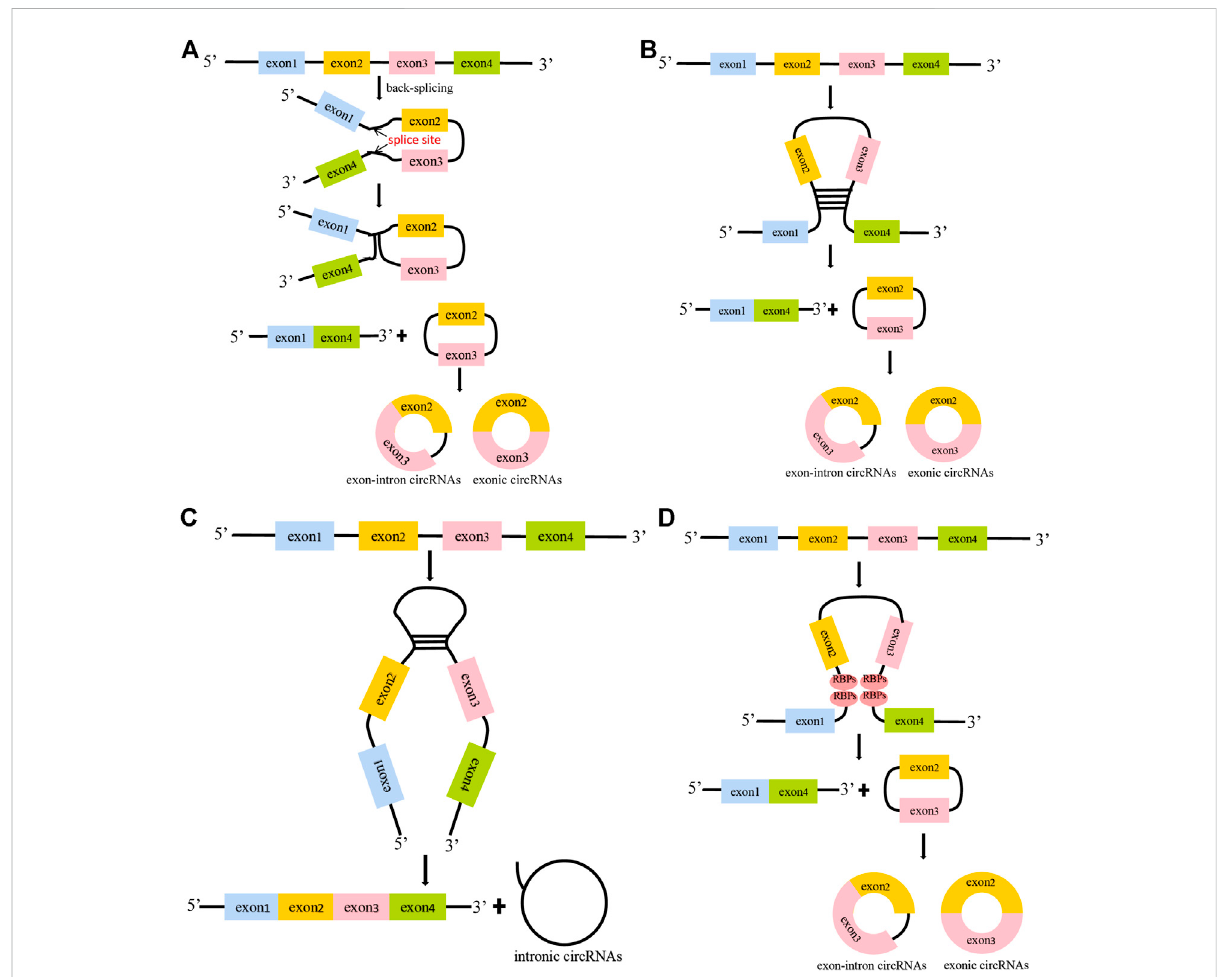
FIGURE 2 TheformationmechanismsofcircularRNAs. (A) .Lariat-drivencircularization.Thesplicedonorofthedownstreamexonofthepre-mRNAbinds to the splice acceptor of the upstream exon, thereby forming exon-intron circRNAs. When the introns are removed, the exons are linked by 3 – 5 ′ phosphodiester bonds to form exonic circRNAs. (B – C) . Intron pair-driven circularization. The introns fl anking the exons of the pre-mRNA are base -paired through ALU repeats to generate exon-intron circRNAs, exonic circRNAs and intronic circRNAs. (D) . RBPs-mediated circularization. RBPs bind to RBP binding sites in intron sequences, and the interaction promotes the production of